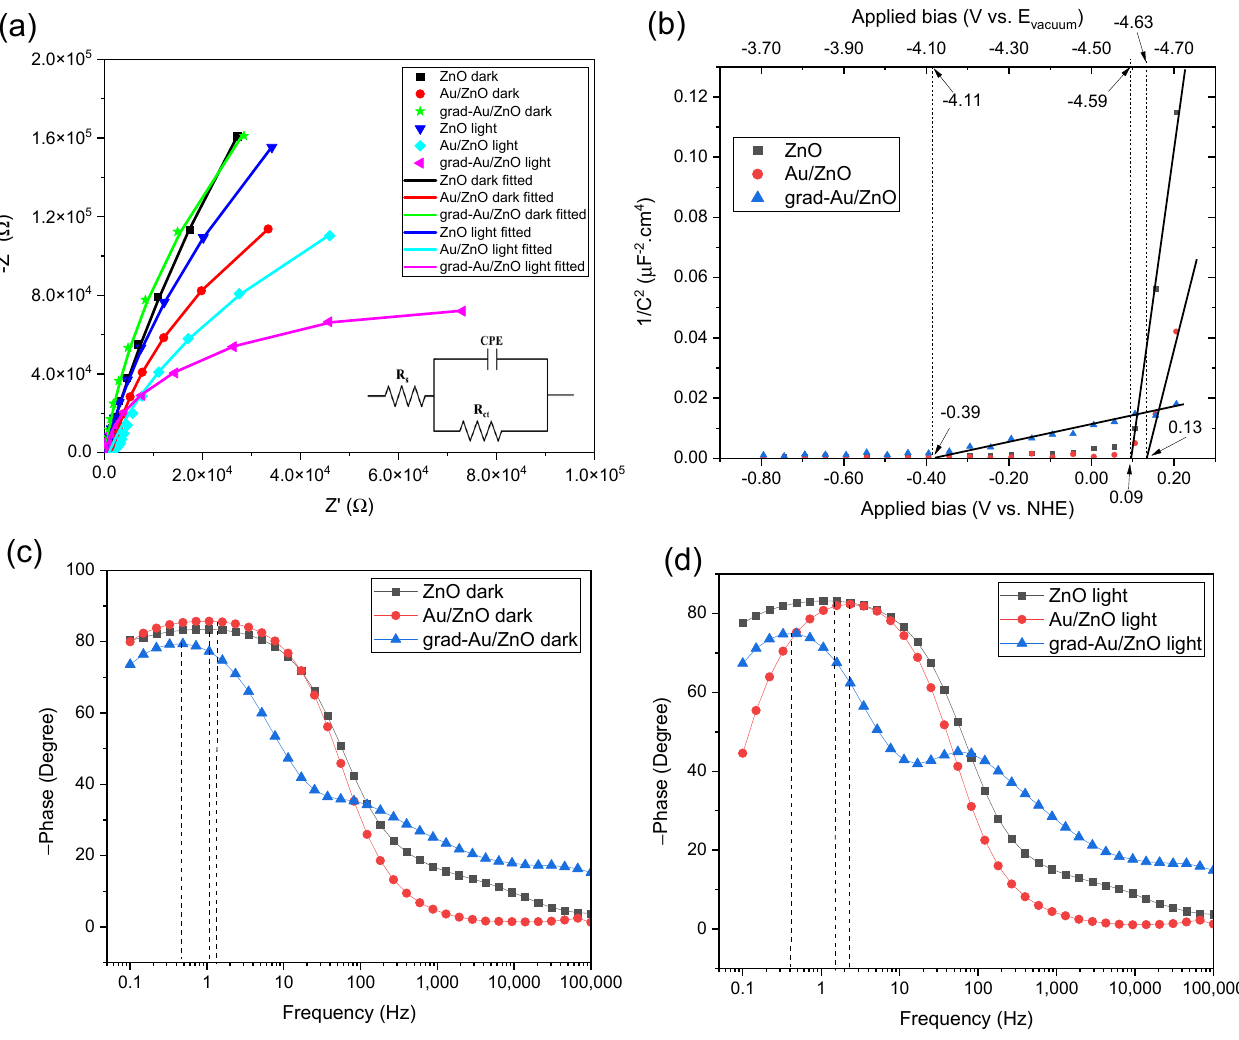
Figure 7. ( a ) EIS data in the Nyquist plots in the absence and presence of illumination (the inset is the equivalent circuit model used for fitting), ( b ) Mott-Schottky plots, ( c ) Bode phase plots at dark, and ( d ) Bode phase plots at light for all the photoanodes.